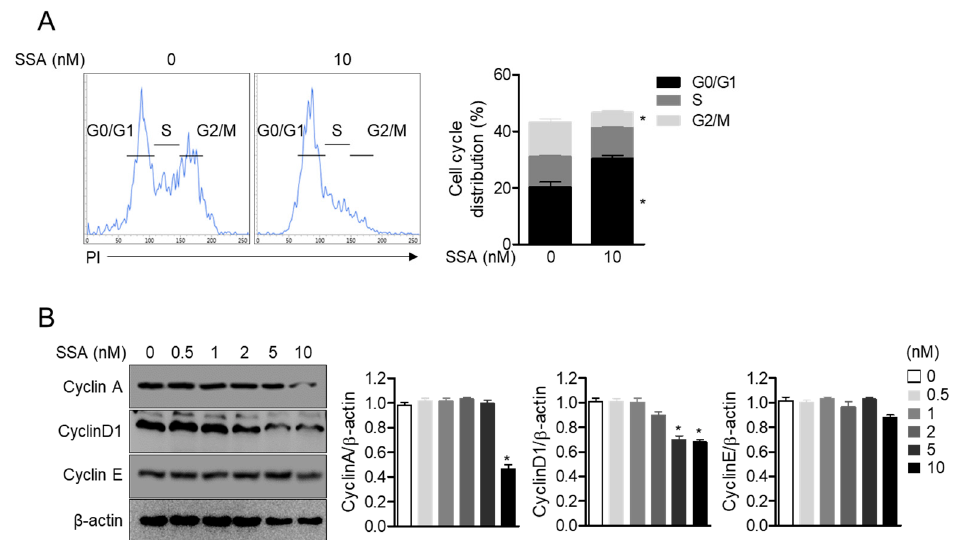
Figure 5. Treatment with 10 nM salinosporamide A leads to cell cycle arrest and regulates cyclin-dependent kinase expression in T cells. ( A ) Cell cycle distribution of T cells treated with 10 nM salinosporamide A for 24 h was determined by a PI staining assay using flow cytometry. ( B ) Expression levels of the indicated proteins were detected by western blot analysis of Jurkat T cells treated with the indicated concentration of salinosporamide A (0–10 nM) for 24 h. The mean value of three experiments ± SEM is presented. * p < 0.05 between control cells.